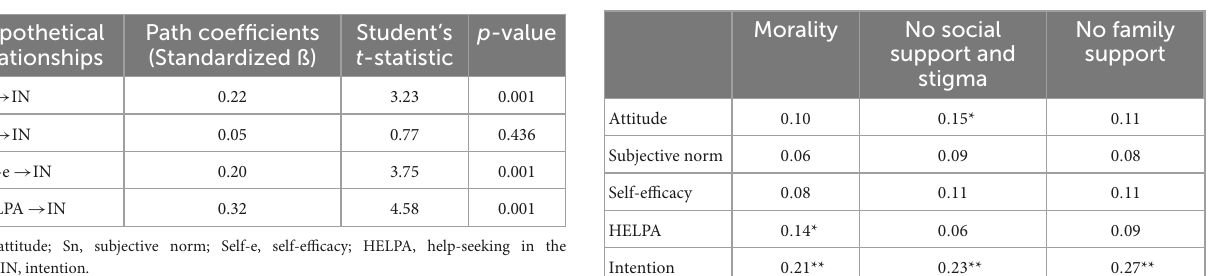
TABLE 6 Path coefficients (standardized regression coefficients).